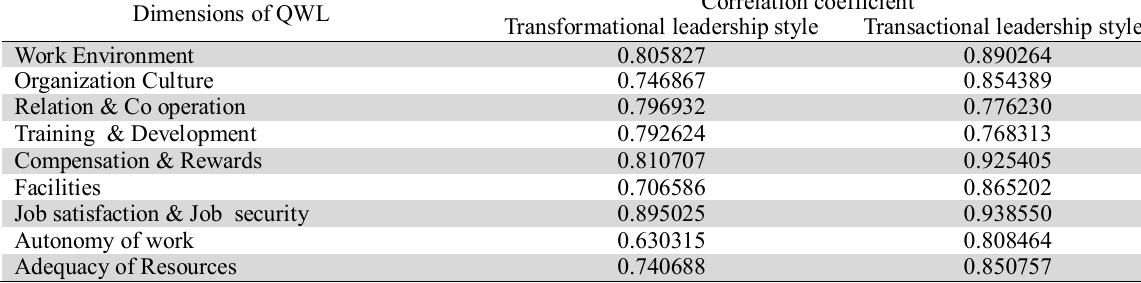
Correlation between QWL and Components of